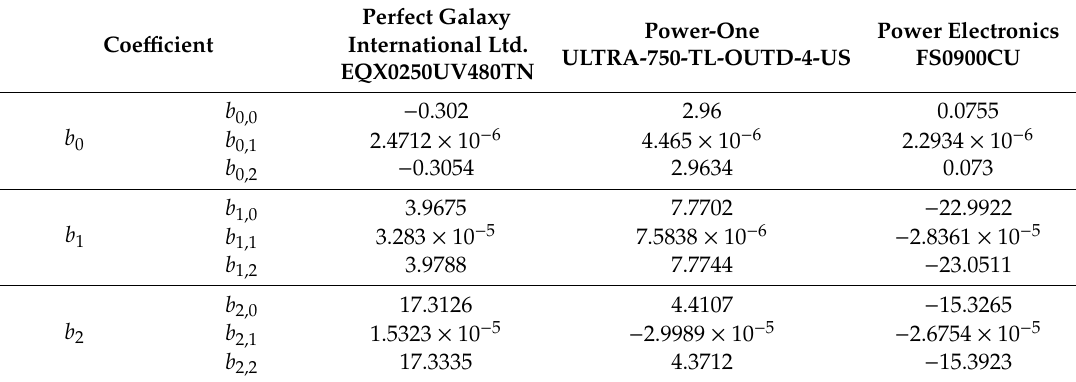
Table 10. Driesse coe ffi